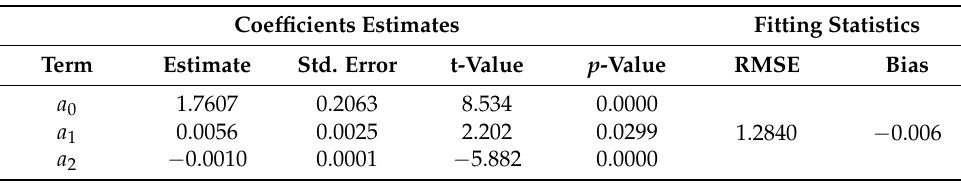
Table 4. Estimated regression coefficients and fitting performance.